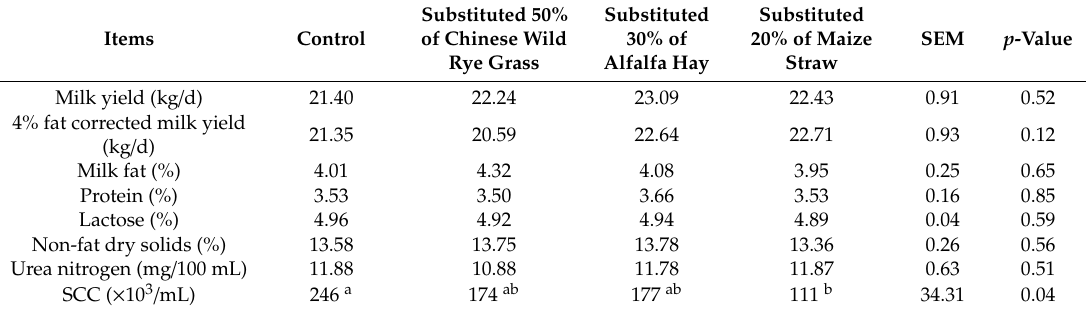
Table 7. E ff ects of microbial anaerobic fermented whole Zhang hybrid millet on milk components and milk